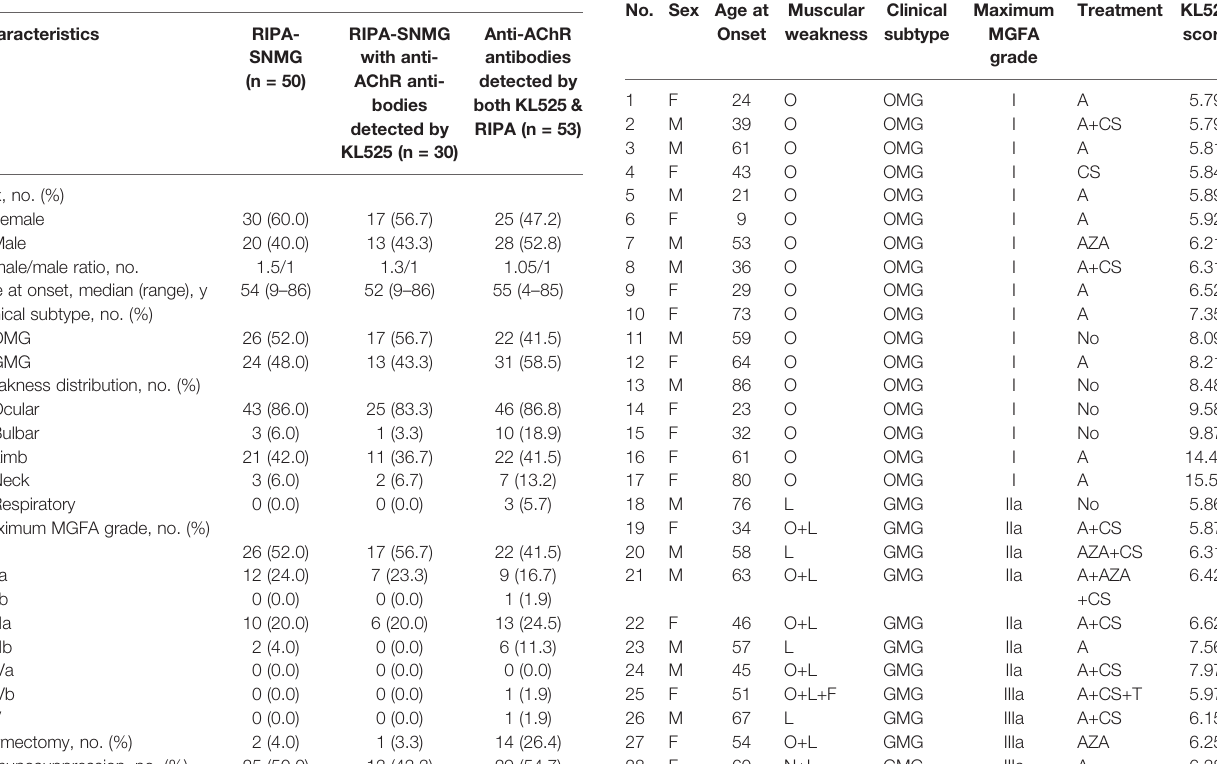
TABLE 1 | Comparison of clinical features of RIPA-SNMG patients, RIPA-SNMG patients with anti-AChR antibodies detected by the KL525 CBA and patients with anti-AChR antibodies detected by both the KL525 CBA & RIPA. Characteristics